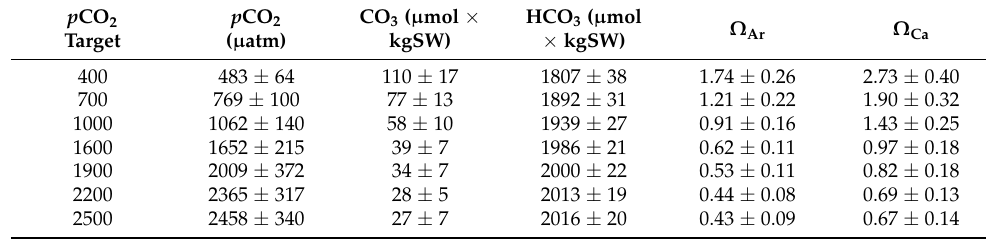
Table 2. Calculated seawater parameters over the course of OA treatments and their respective un- certainties. The total uncertainty (U total ) for each calculated parameter is reported as the combination of propagated measured uncertainties as reported in Table 1 and the variability of each parameter over the course of each experiment.